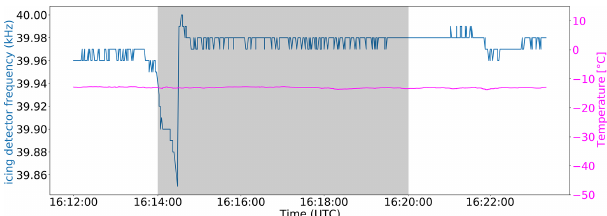
Figure 10. RICE oscillation frequency (blue) and temperature at Citation II level (magenta). Icing periods are indicated by a sharp drop in RICE frequency due to ice accumulation at the sensor tip. The shaded area represents the associated flight interval on 13